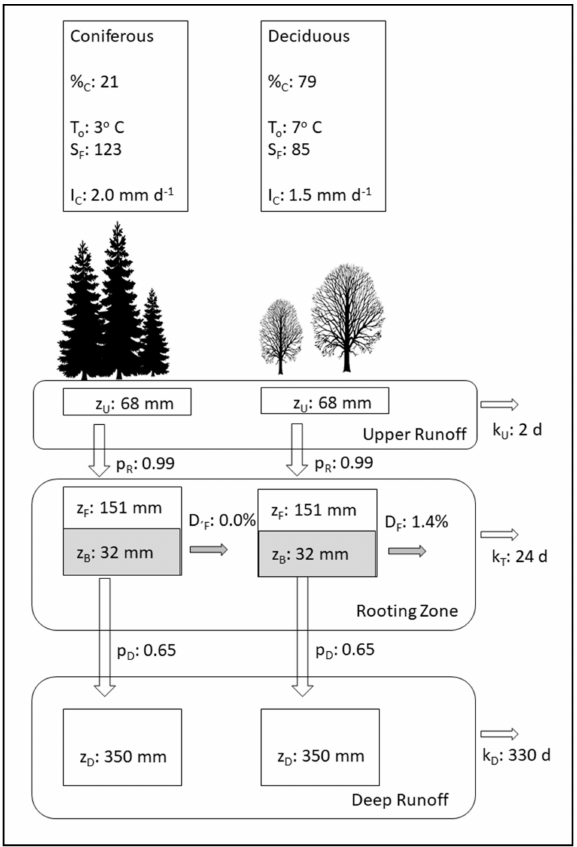
Figure 3. Schematic of PERSiST model setup used in the simulations presented here. Depth of liquid water (mm d − 1 ) leaving a bucket each day was estimated as the depth of freely draining water (z U , z F and z D for the upper runoff, rooting zone and deep runoff buckets respectively) divided by a characteristic time constant, k. Characteristic time constants for the upper runoff, rooting zone and deep runoff buckets are 2 d, 24 d and 330 d,